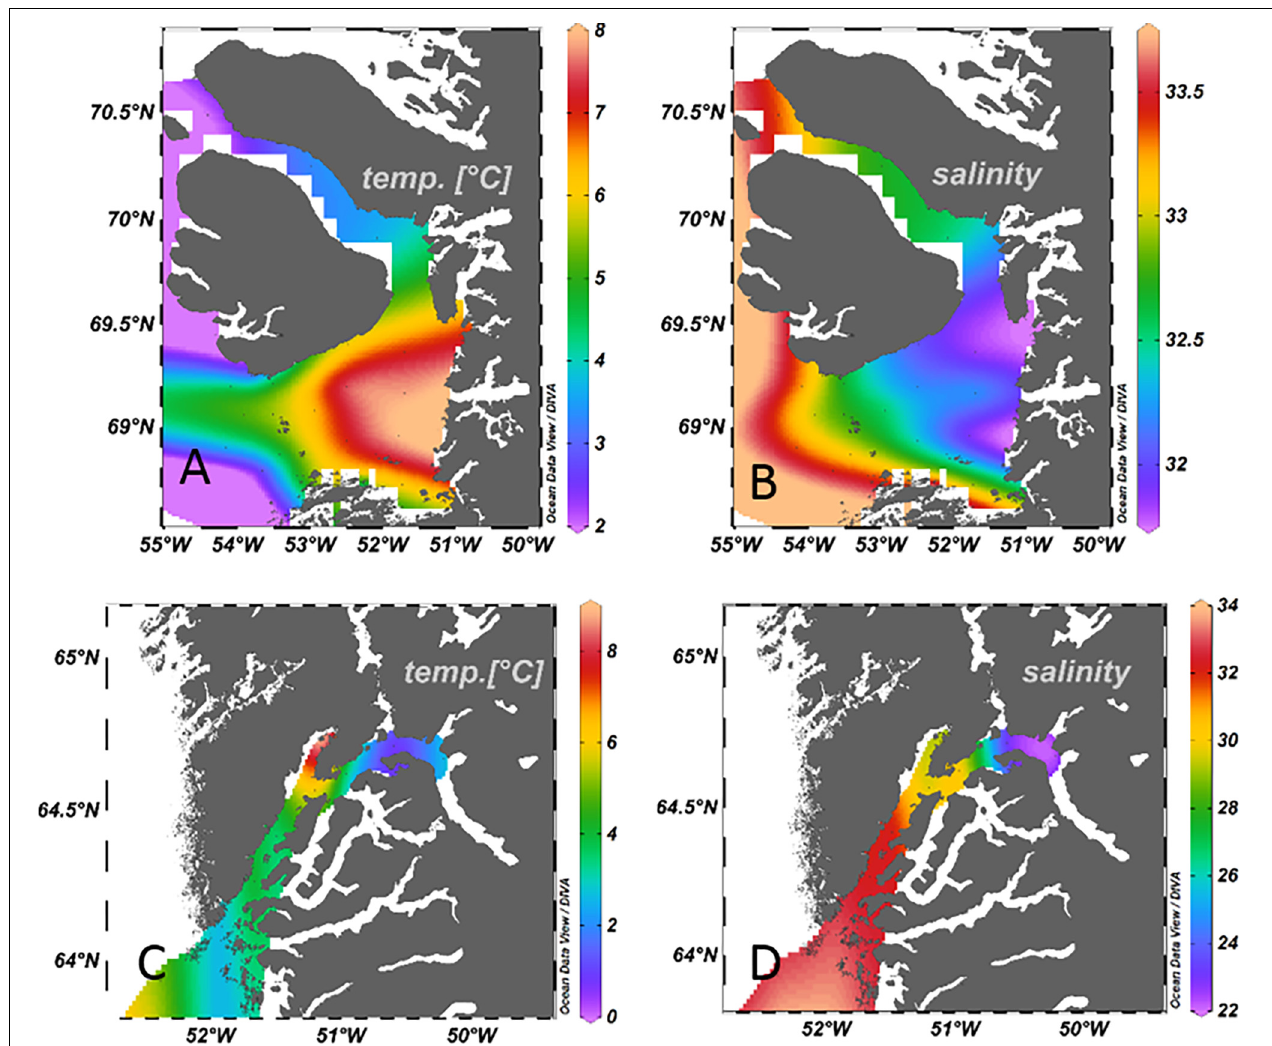
FIGURE 3 | Hydrography in the Vaigat-Disko Bay and Godthabsfjord. Surface maps of temperature and salinity in the Vaigat-Disko Bay (A,B) and Godthabsfjord (C,D) , respectively.